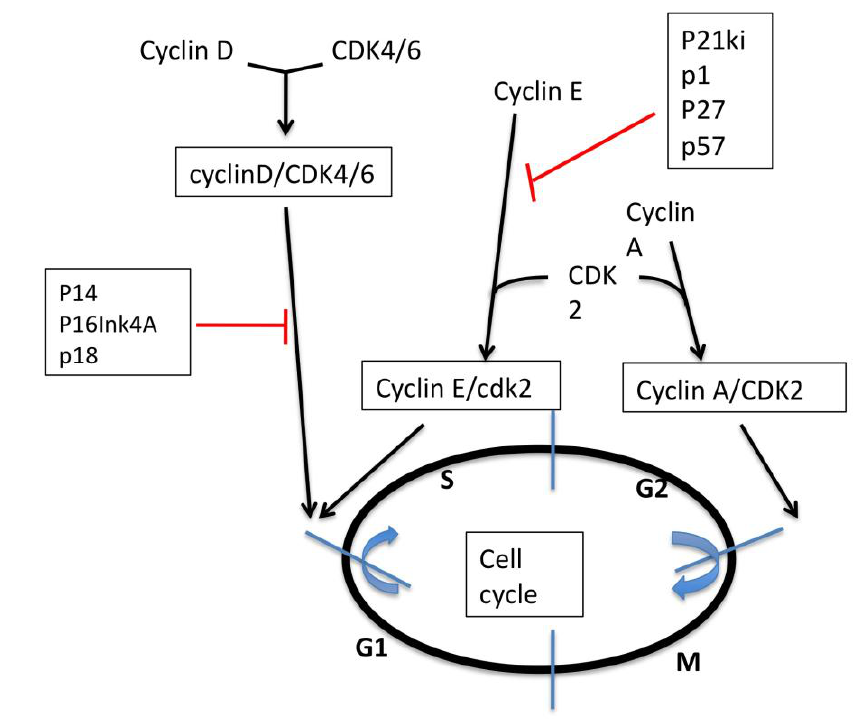
Figure 1. Brief schematic representation of cell cycle